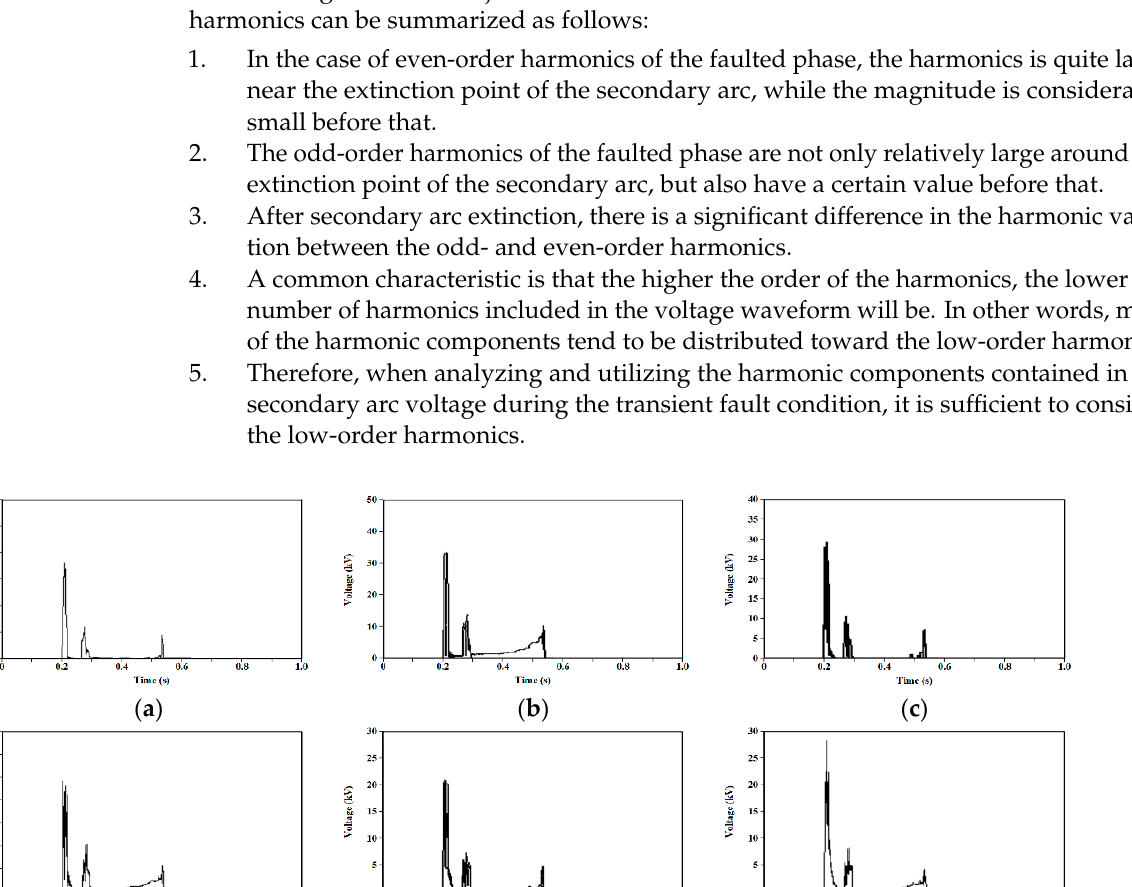
Figure 7. Total operation concept of the proposed ASPAR scheme. 4.1. Algorithm for Discrimination of the Fault Type—Sequence 1